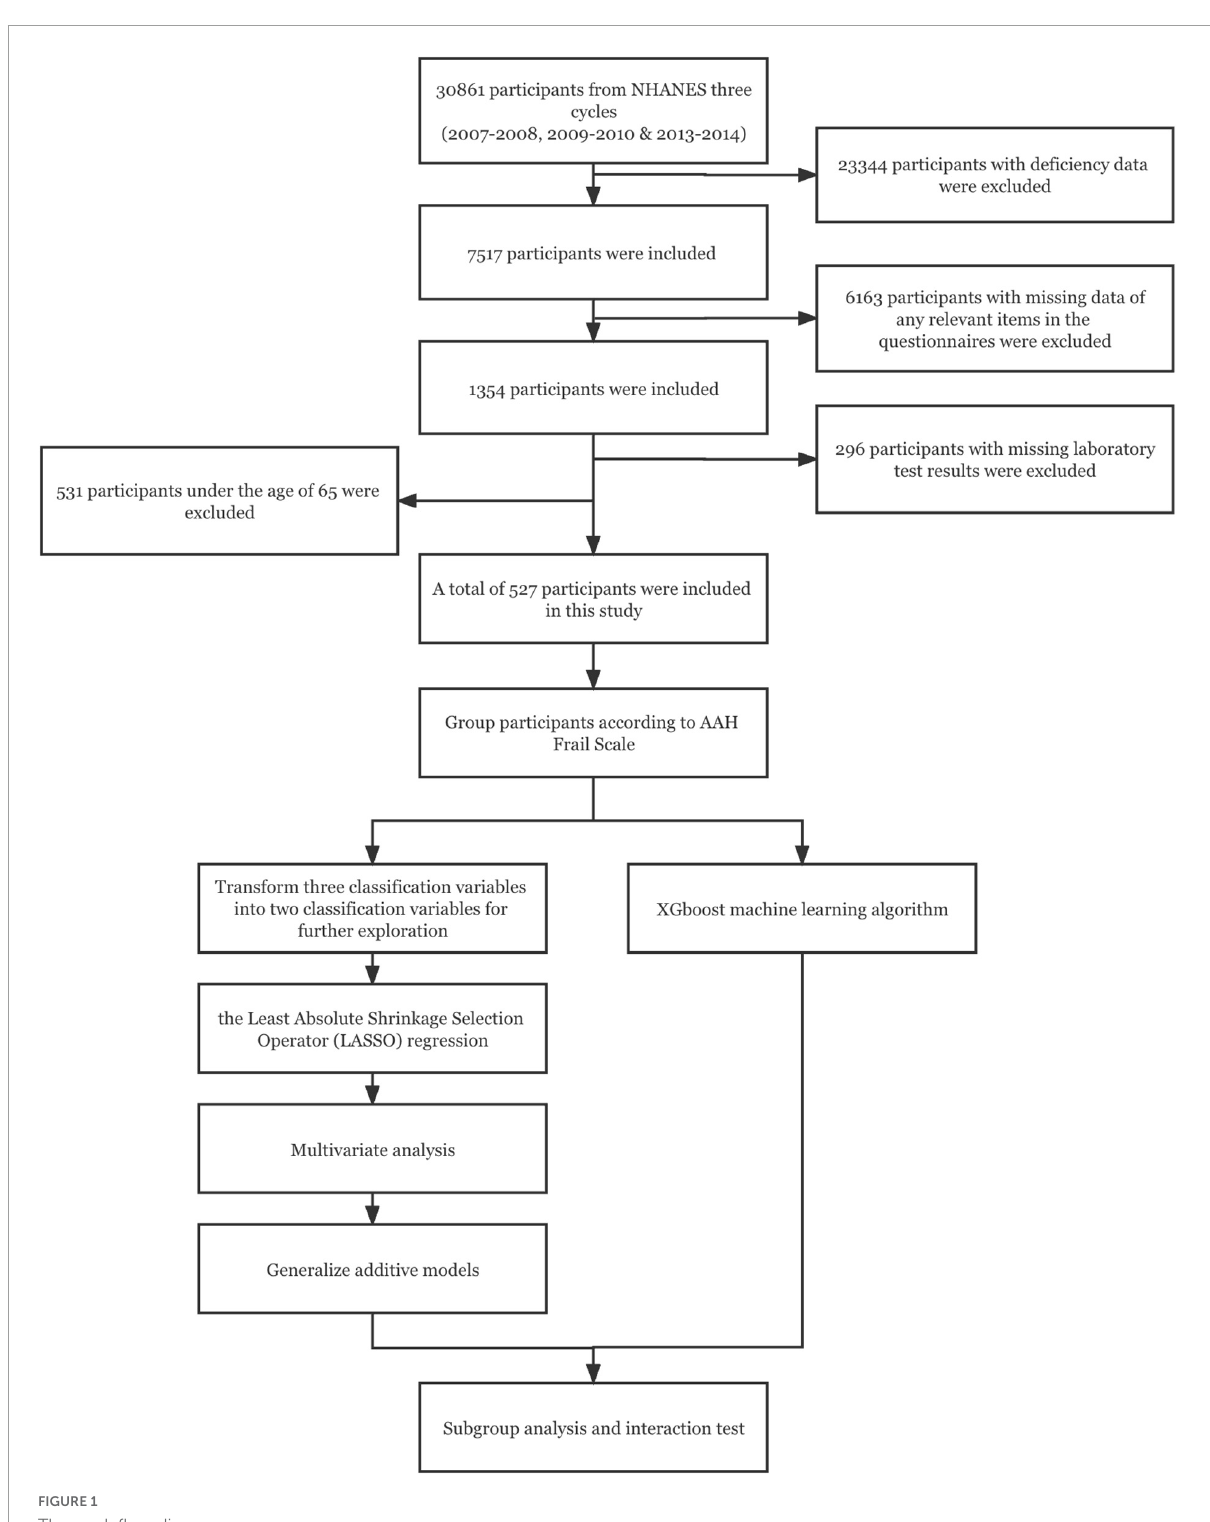
FIGURE1 The work flow